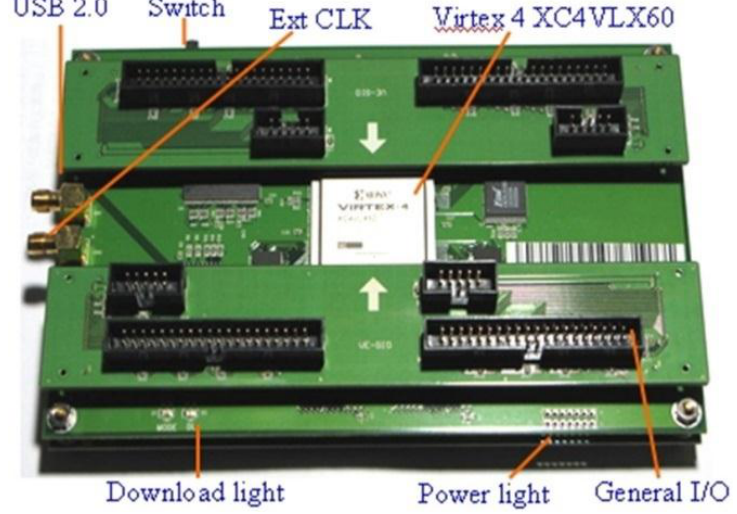
Figure 22. SMIMS VeriEnterprise ® FPGA development platform.